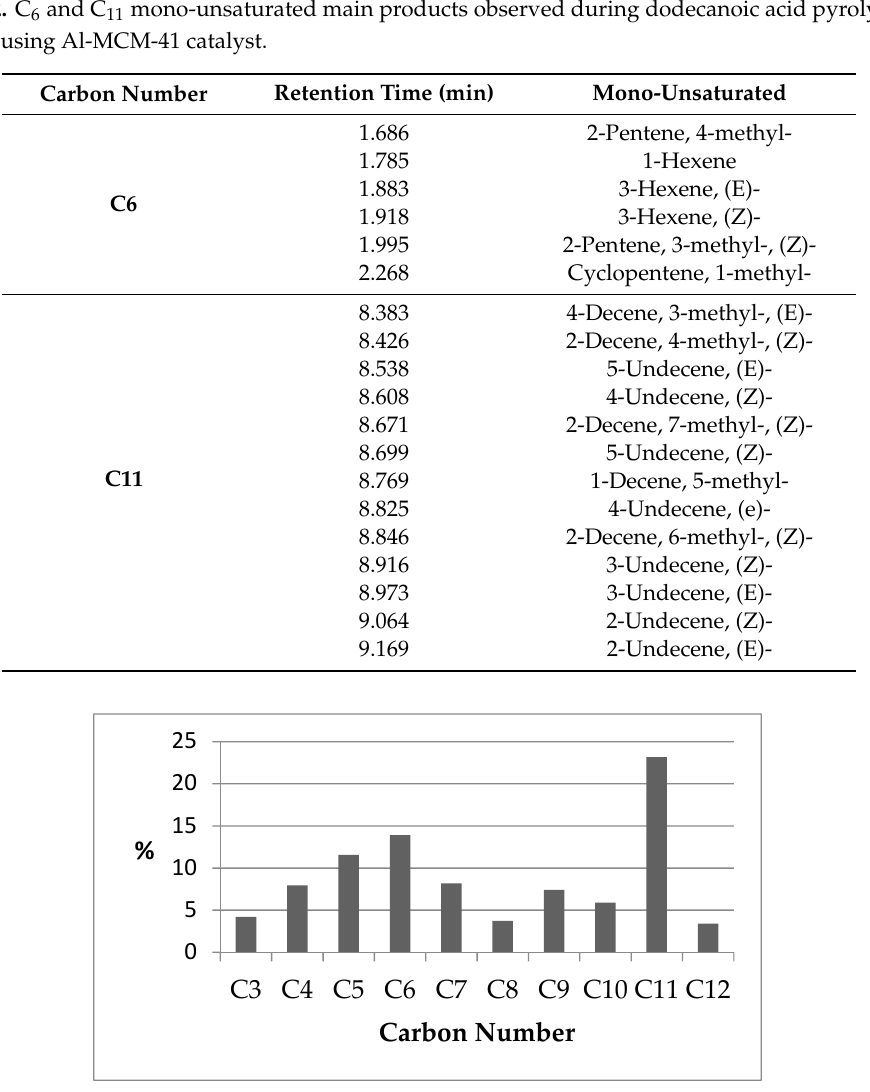
Figure 10. Mono-unsaturated isomers’ distribution from pyrolysis of lauric acid at 650 °C, in the presence of Al-MCM-41.